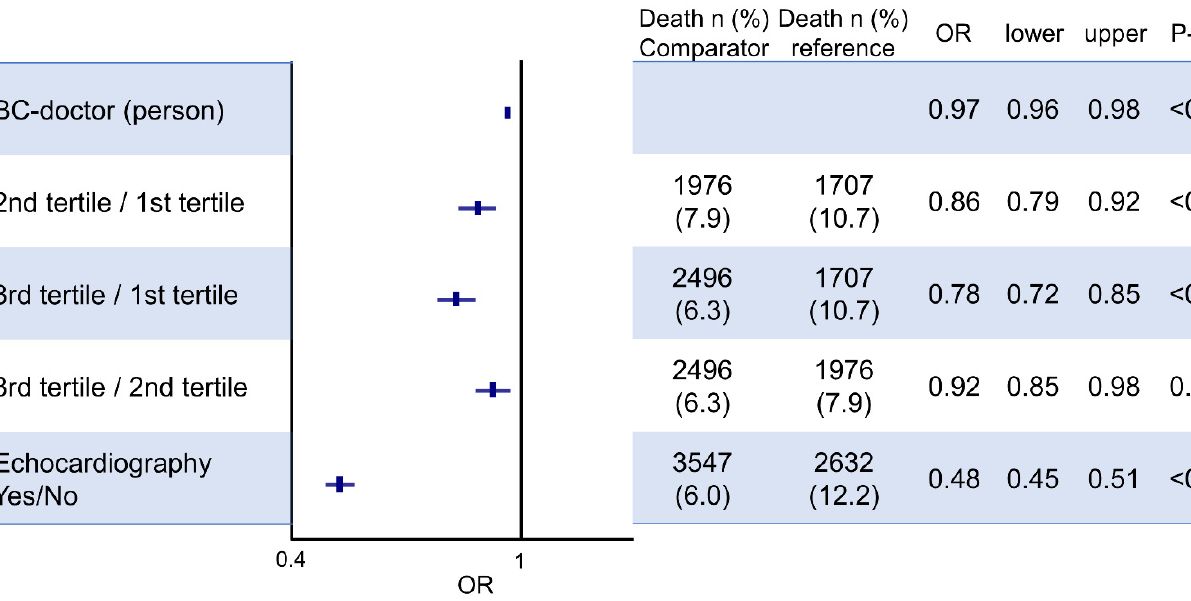
Figure 3. Odds ratio of in-hospital mortality. BC, board-certified. Dots and lines mean odds ratio (OR) and 95% CI, respec- tively.